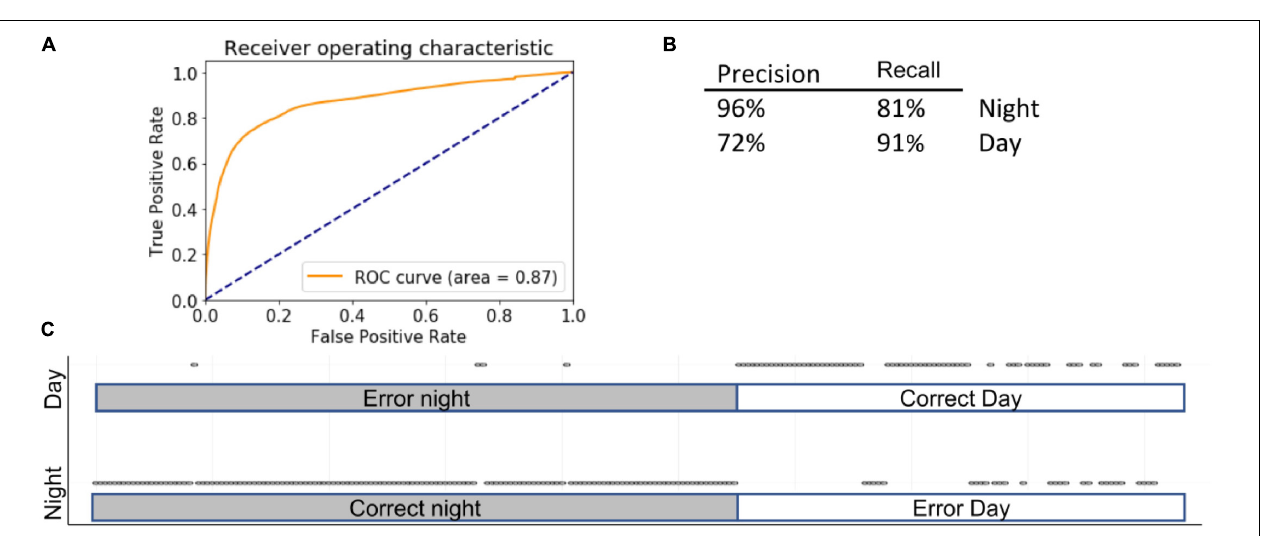
FIGURE 5 | Summary of SVM. Inserts show ROC (A) curve, precision summary (B) , and graphical representation of the ratio of true positives to false positives (C) . Open circles represent predictions. The majority of predictions are correct, and therefore circles overlap into apparent lines. Dots above marked bars represent incorrect